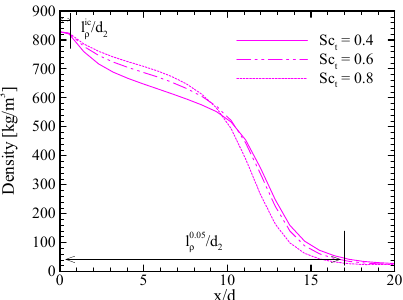
Figure 16. Time-averaged density profiles along central-axis for near injector field for different turbulent Schmidt numbers.